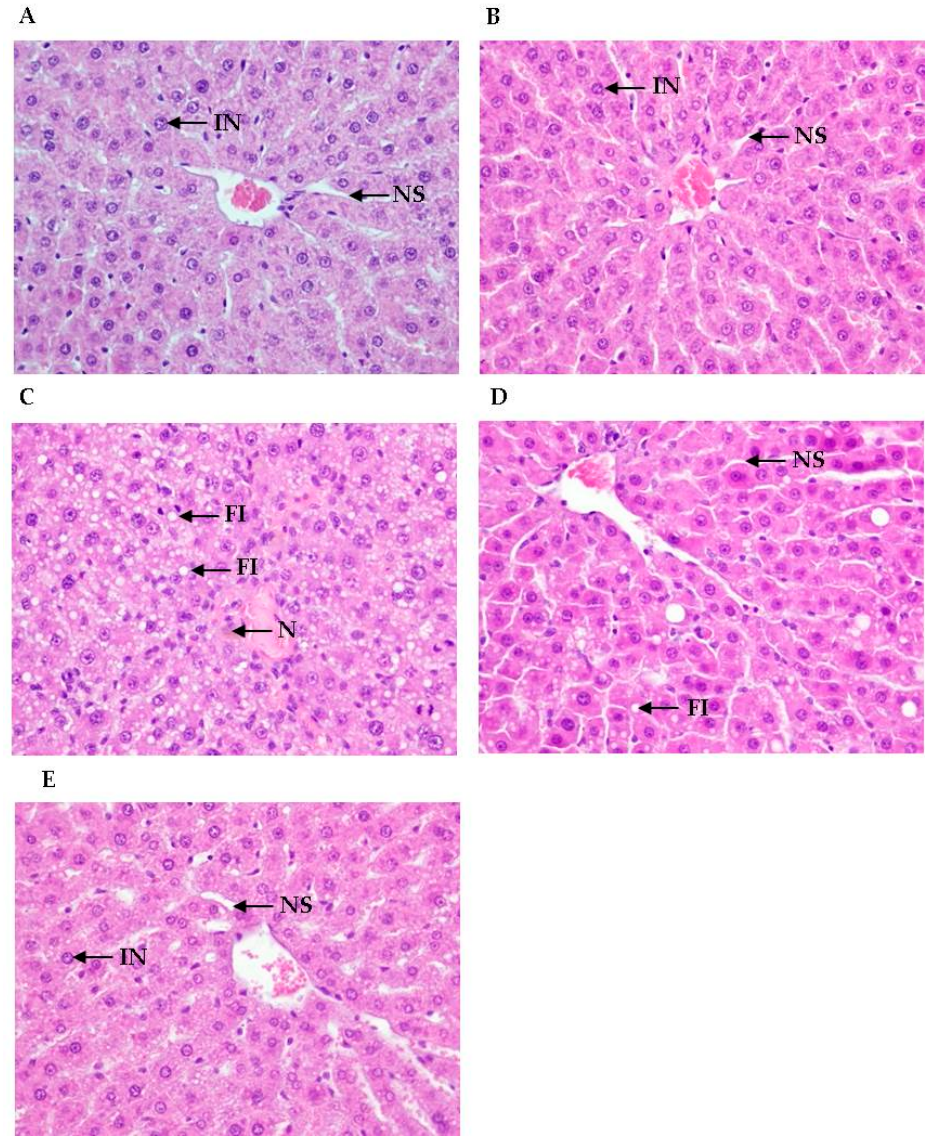
Figure 1. Effects of oral administration of GE50 over six consecutive weeks on histopathological changes in the livers of rats treated with ethanol + CCl 4 . Hematoxylin/Eosin staining (H&E), 400×. ( A ) Liver section from the control group demonstrating normal hepatic architecture with intact nucleus (IN) and normal sinusoids (NS); ( B ) GE50; ( C ) Section of ethanol + CCl 4 (EC)-induced damaged liver showing highly deformed hepatic architecture with fatty lesion due to fatty infiltration (FI) and necrosis (N); (D ) EC + GE50; (E ) Liver section from EC + silymarin-treated group showing improved hepatocellular architecture with IN and